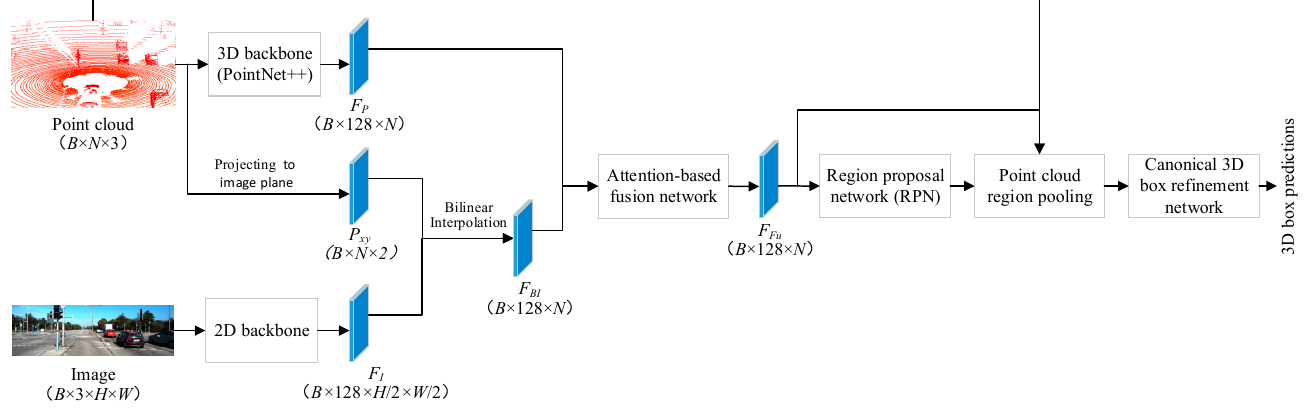
Figure 1. Network architecture of the FuDNN. B , N , H, and W represent the batch size of FuDNN, the number of LiDAR points, the height, and width of image, respectively. The input of FuDNN is point clouds and RGB images. The shape of input images is a matrix of B × 3 × H × W , where B , H, and W represent the batch size of FuDNN,